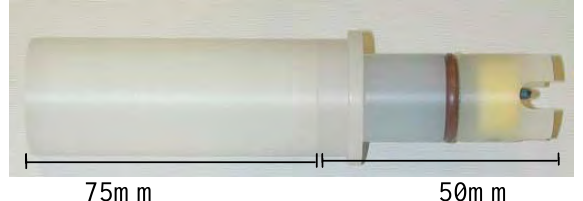
Figure 1b. Side profile of the sensor housing into which the ET